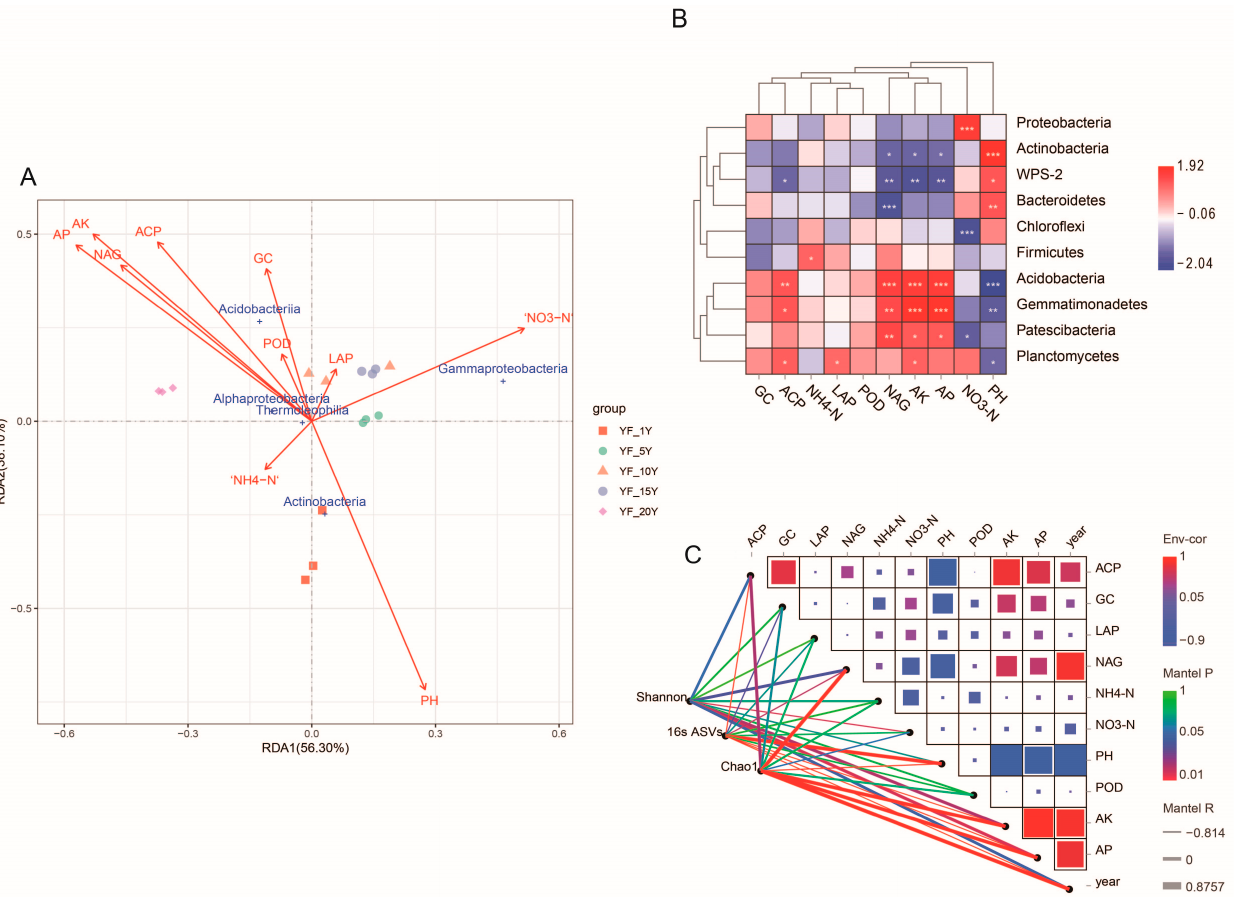
Figure 5. Analysis of the relationship between environmental factors and microbial community structure. ( A ) The redundancy analysis (RDA) of bacterial communities and soil properties in different treatments. ( B ) Correlations between the 10 dominant bacterial phyla and soil properties. * p < 0.05; ** p < 0.01; *** p < 0.001. ( C ) The relationship between environmental factors and soil bacterial community composition. Pairwise comparison of environmental factors and color gradients representing Pearson’s correlation coefficient. The 16s ASVs, Chao Ⅰ, and Shannon were related to each environmental factor using the Mantel test. Edge color revealed the statistical significance based on significance. Edge width corresponded to the Mantel’s statistic for the corresponding distance cor- relations. AK: available potassium; AP: available phosphorous; GC: β -glucosidase; ACP: acid phos-